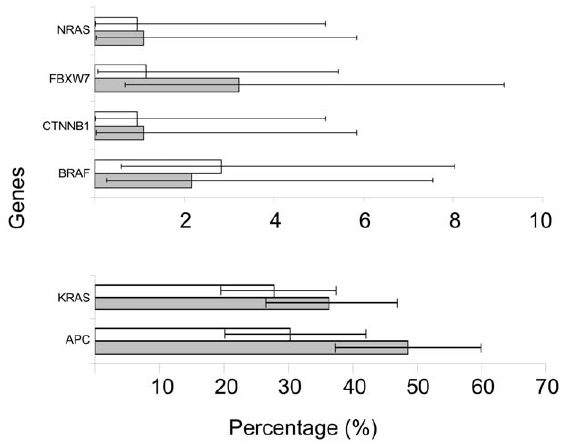
Figure 2. The mutation percentage for the flat and polypoid adenomas. Only genes that show a mutation in one of the adenoma types are included. White bars represent flat adenomas and grey bars polypoid adenomas. Percentages are calculated using random impu- tation, horizontal bars represent the 95% confidence interval.